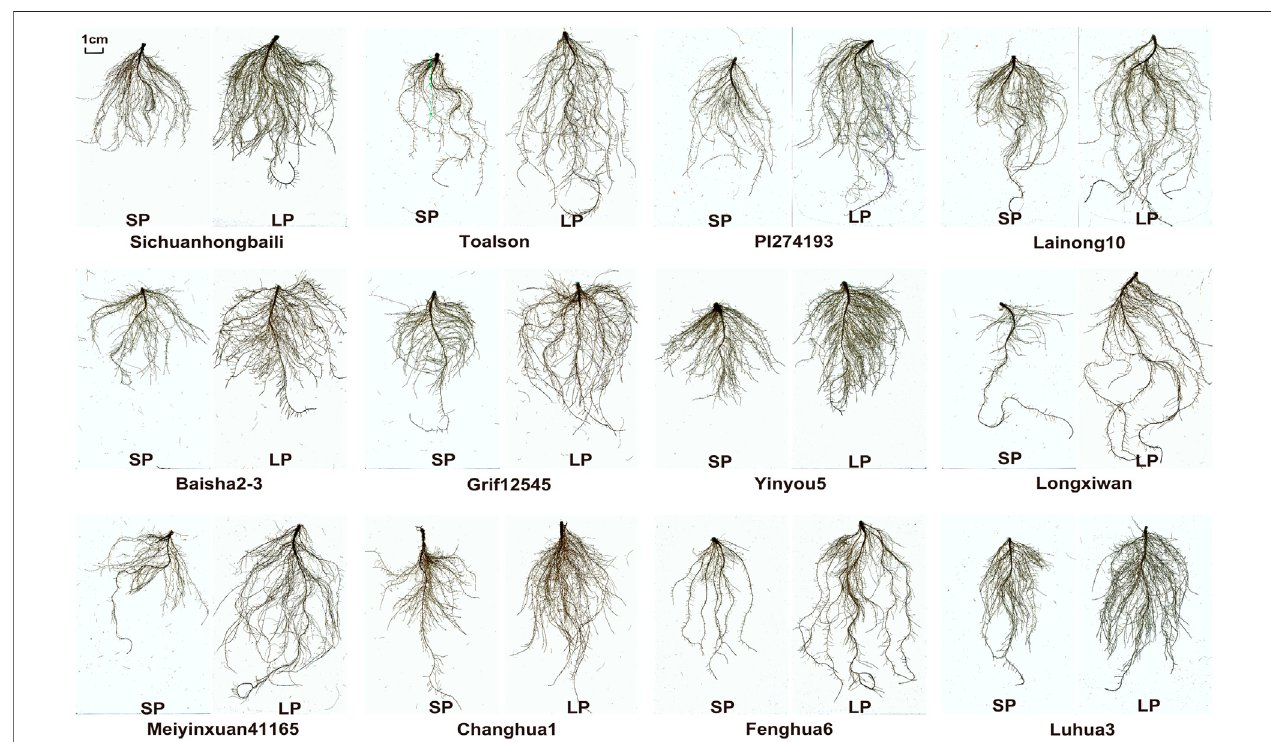
FIGURE 1 | Root morphological of 12 germplasms under low-P (LP) and suf fi cient-P (SP) conditions.